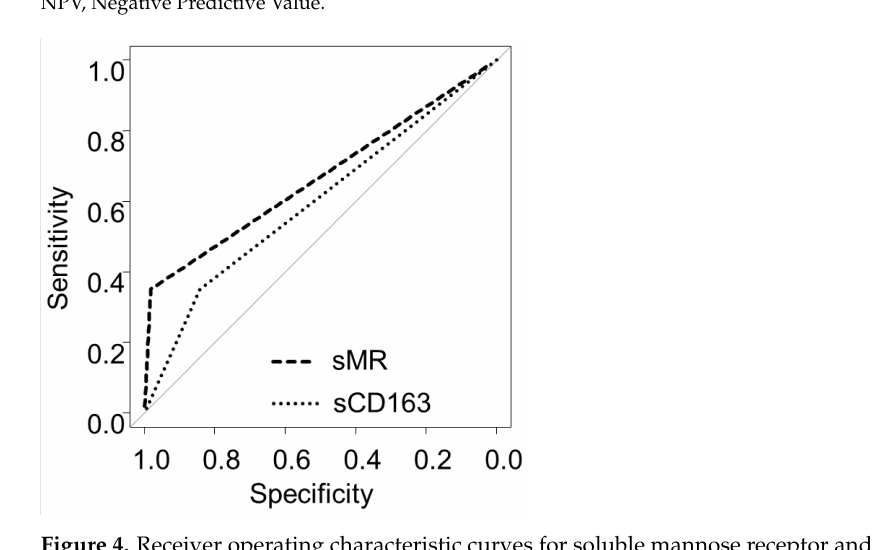
Figure 4. Receiver operating characteristic curves for soluble mannose receptor and soluble CD163 alone and combined.